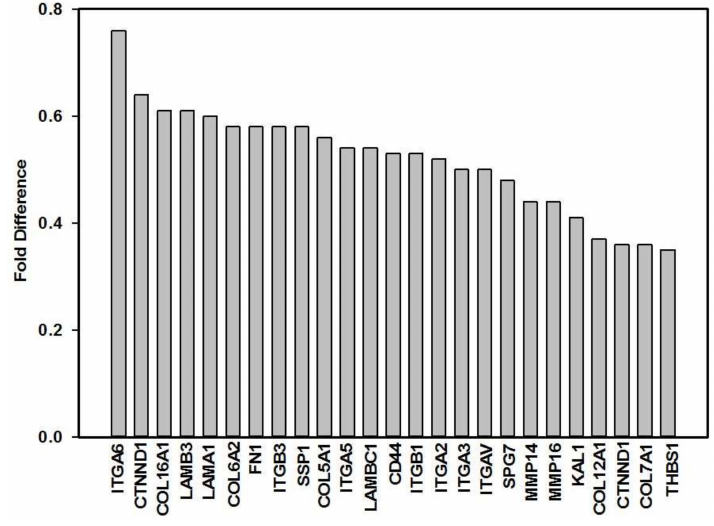
Figure 1. Significant down-regulation (fold difference <1) of genes related to CAMs in diabetic wounded cells irradiated with 660 nm at 5 J/cm 2